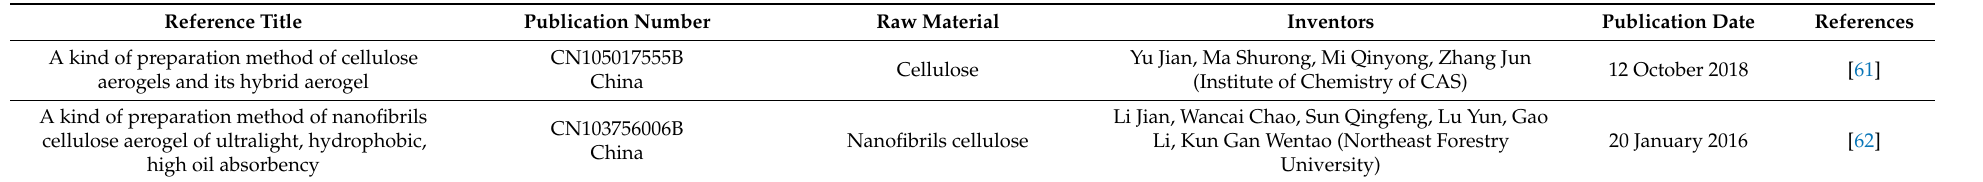
Table 3. Recent selected patents on cellulose-based aerogels and